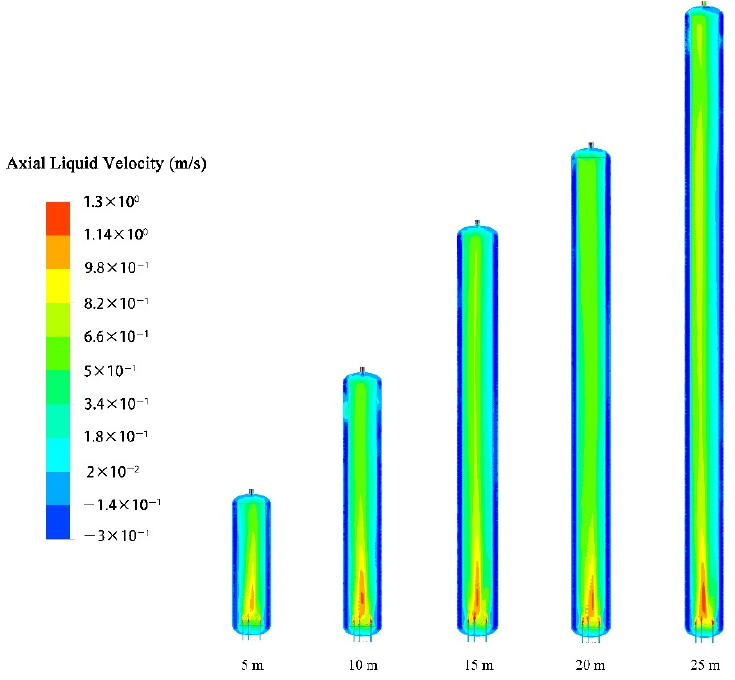
Figure 11. Axial liquid velocity distribution at different total column heights with U Gr of 0.0389 m/s.